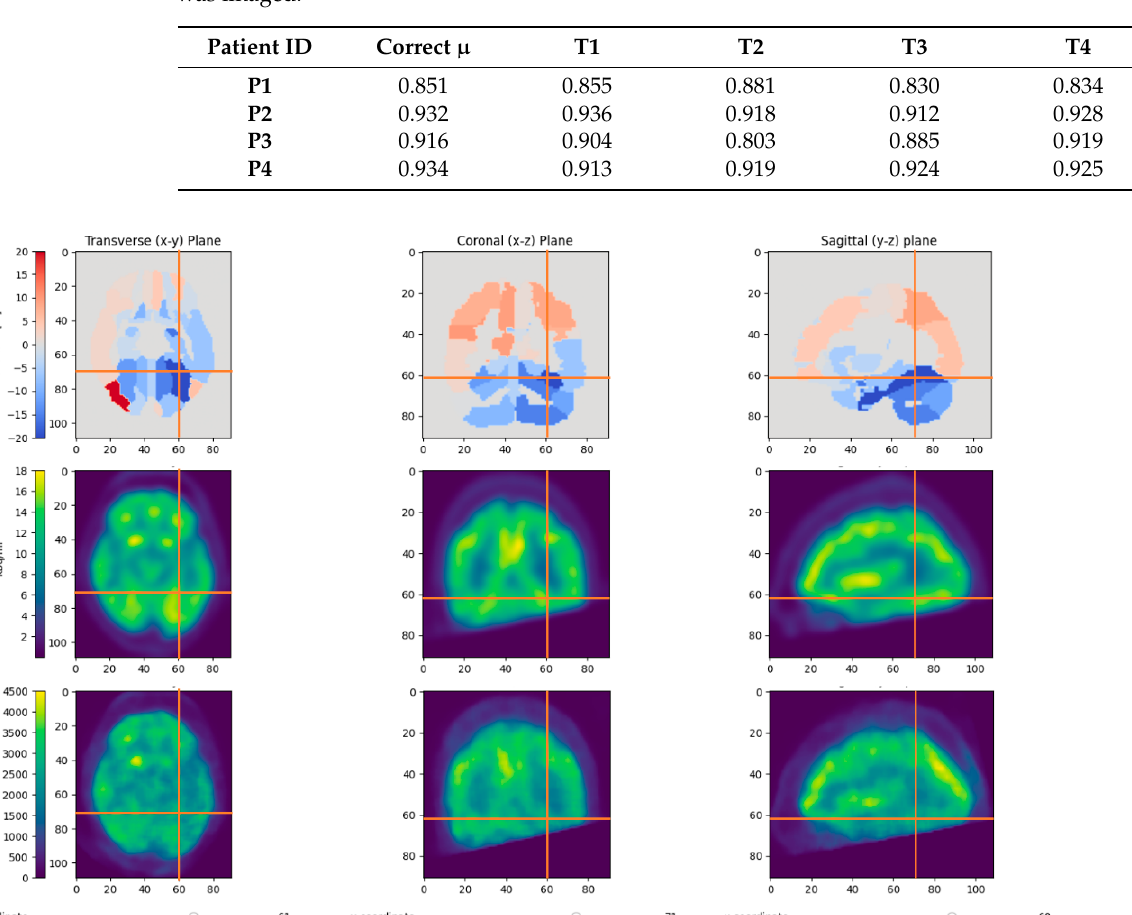
Table 2. Pearson correlation coefficients between BPET reconstructions and reference PET. The “correct µ ” column shows the results with the µ -map obtained from the CT of the patient that was imaged.